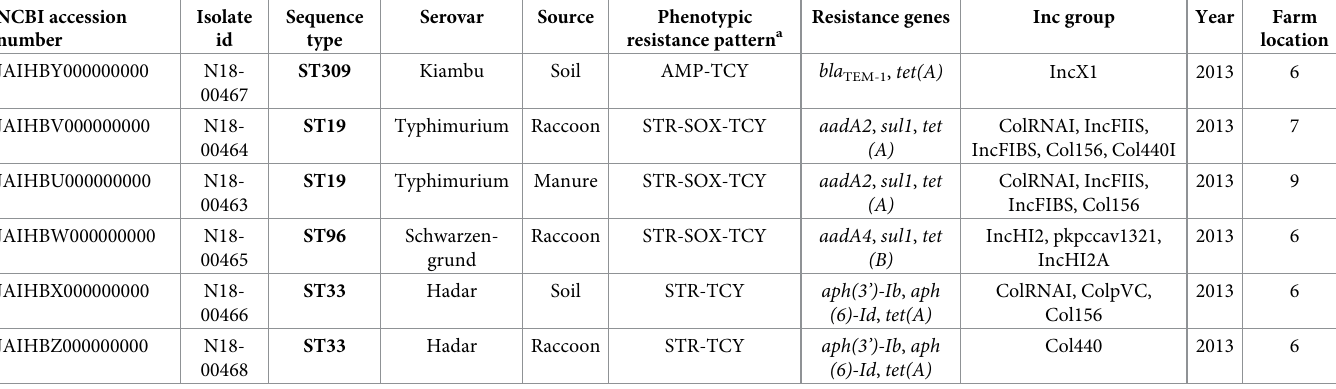
Table 1. Resistance genes and plasmid incompatibility (Inc) groups identified in silico among phenotypically resistant Salmonella enterica from raccoons, swine manure pits, and soil samples on swine farms in southern Ontario, Canada 2011–2013 (n =